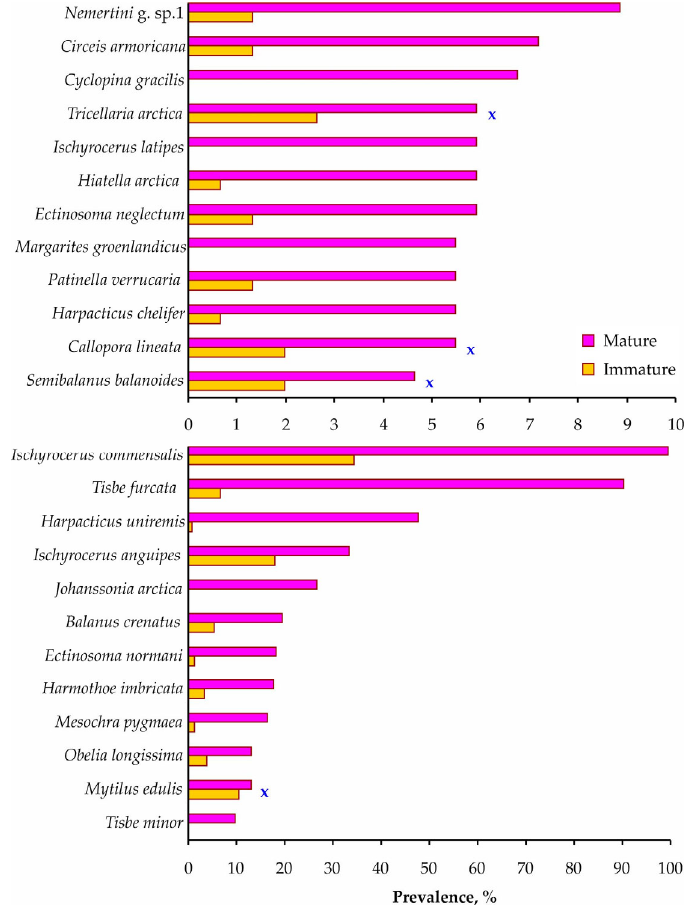
Figure 5. Total infestation prevalence on Paralithodes camtschaticus immature and mature individuals in Dalnezelenetskaya Bay in summers during the period 2009–2013. X indicates insignificant differences (Chi ‐ squared test, p > 0.05).